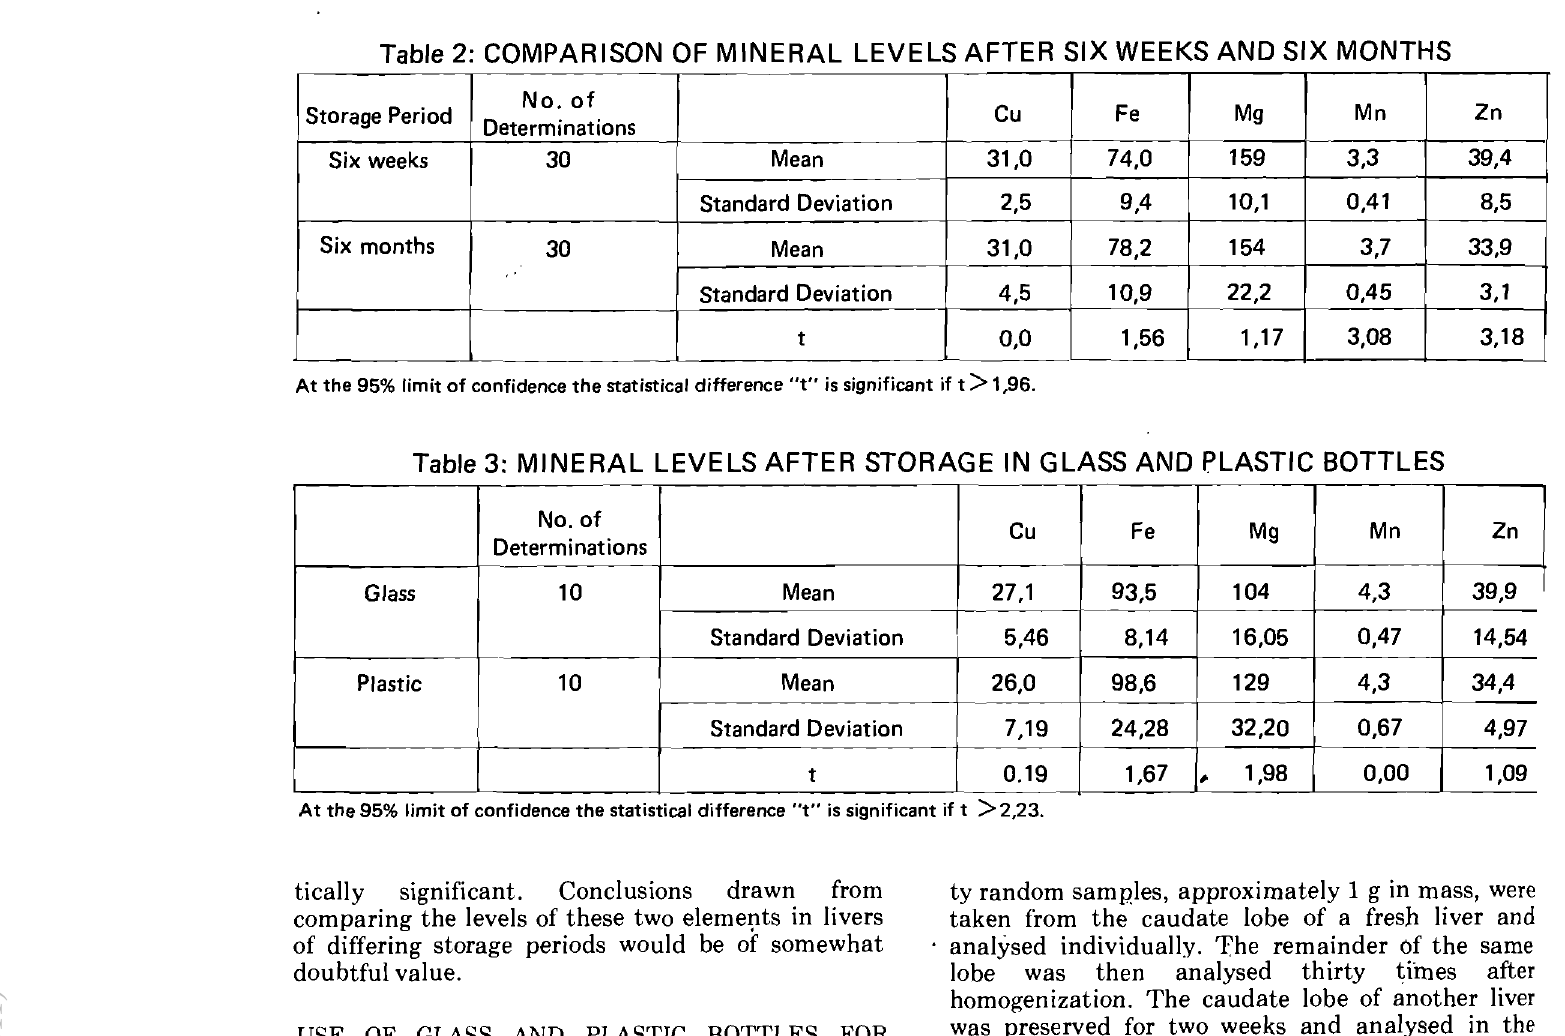
Table 2: COMPARISON OF MINERAL LEVELS AFTER SIX WEEKS AND SIX MONTHS No. of Storage Period